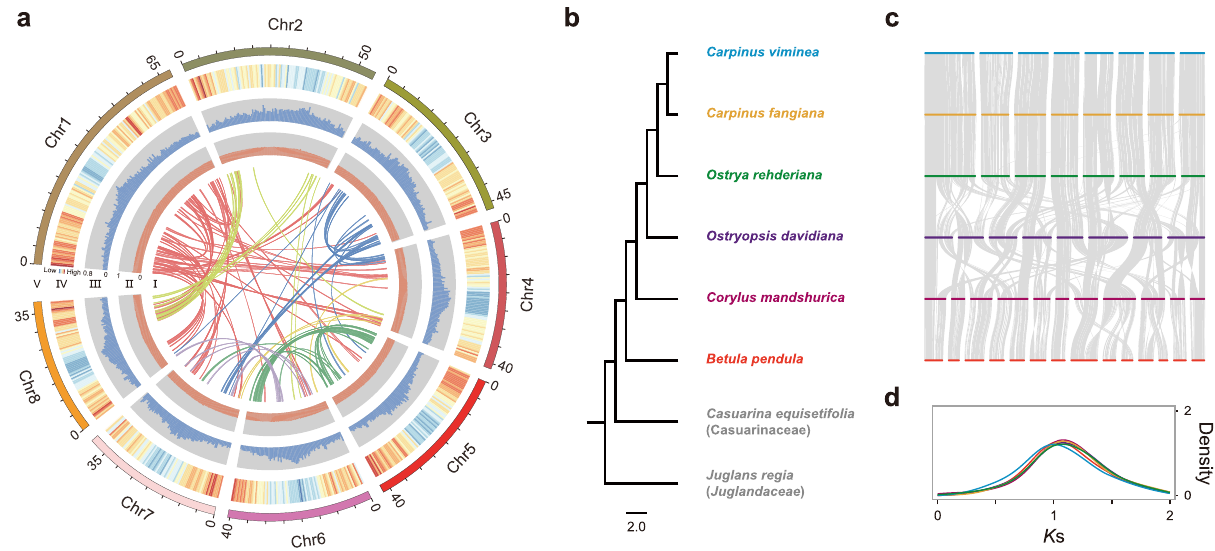
Fig. 1 Genome features of Carpinus viminea and comparative genomic analyses with other species of the same family Betulaceae. a Genome features of the C. viminea assembly, including the synteny information (I), GC (guanine-cytosine) content (II), repeat density (III), gene density (IV), and genome chromosomes (V). b Phylogenomic tree of six Betulaceae species based on the concatenated 4DTv sites. The topology was generated by RAxML, with Casuarina equisetifolia and Juglans regia as outgroups. The bootstrap values for each node were all 100. c MCScanX identi fi ed synteny blocks between six Betulaceae species. The chromosome colors correspond to those in ( b ). d K s distributions within each Betulaceae species. The colors of each species correspond to those in ( b ). Source data are provided as a Source Data fi le.